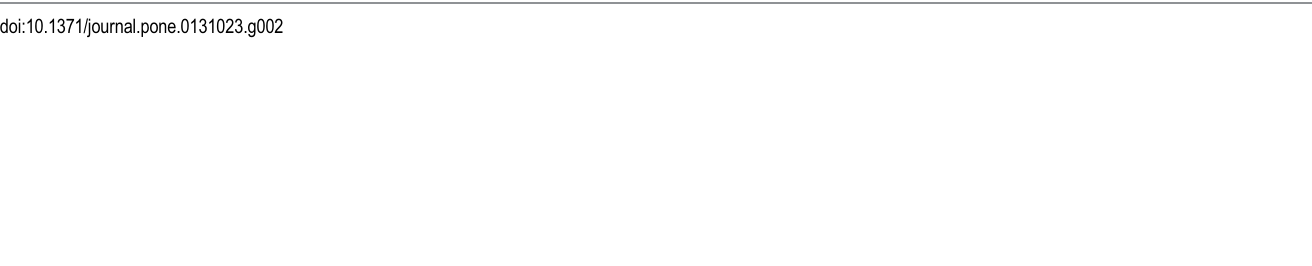
Fig 2. Maximum likelihood tree of the socially parasitic ant genus Myrmoxenus inferred from sequences of the nuclear gene wingless and the mitochondrial gene CO I / CO II. Figures at the nodes represent the percentage of replicate trees with a particular branching pattern (only > 50%). Workerless species are given in